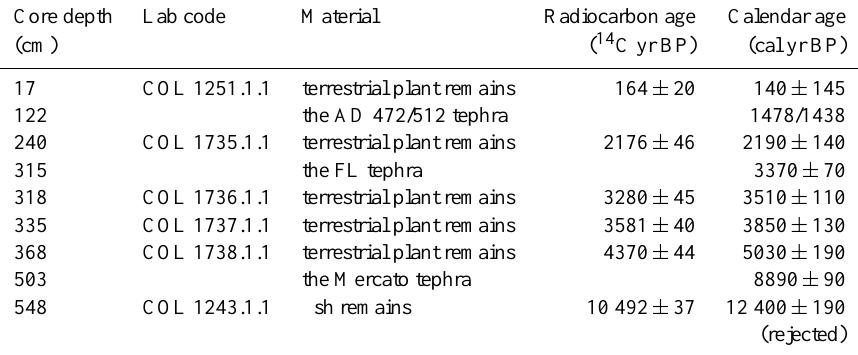
Table 1. Age estimates for core Co1262. The calibration of radiocarbon ages into calendar ages is based on Calib 7.0.2 (Stuiver and Reimer, 1993) and IntCal13 (Reimer et al., 2013) and on a 2 σ uncertainty. Core depth Lab code